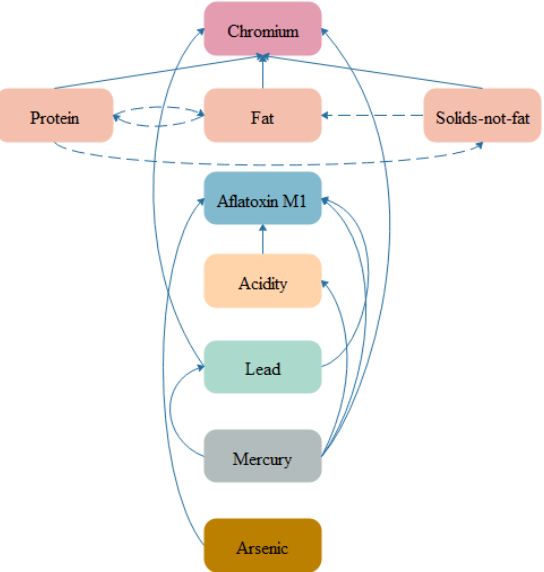
Figure 2. The hierarchical structure of the main influencing factors of infant milk powder.